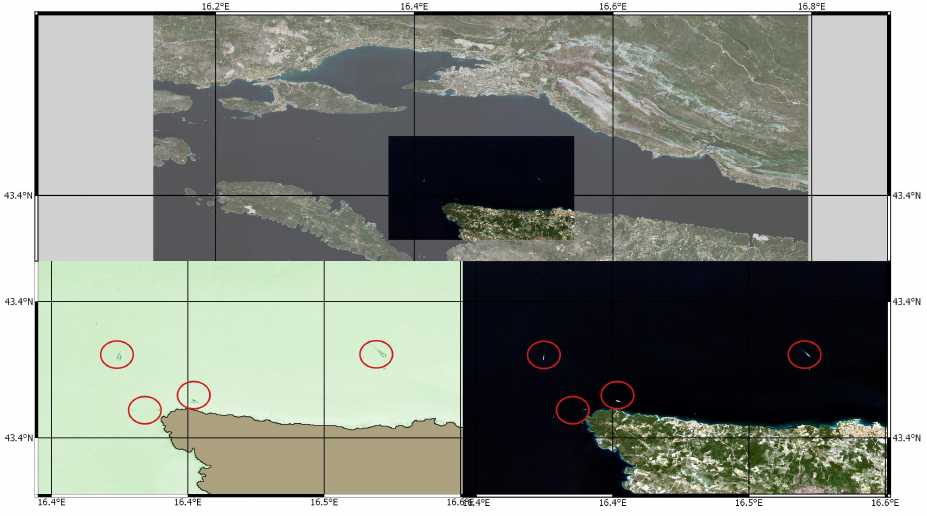
Figure 10. Example of excluded boats from Chl-a calculation in the Braˇc Channel on 30 September